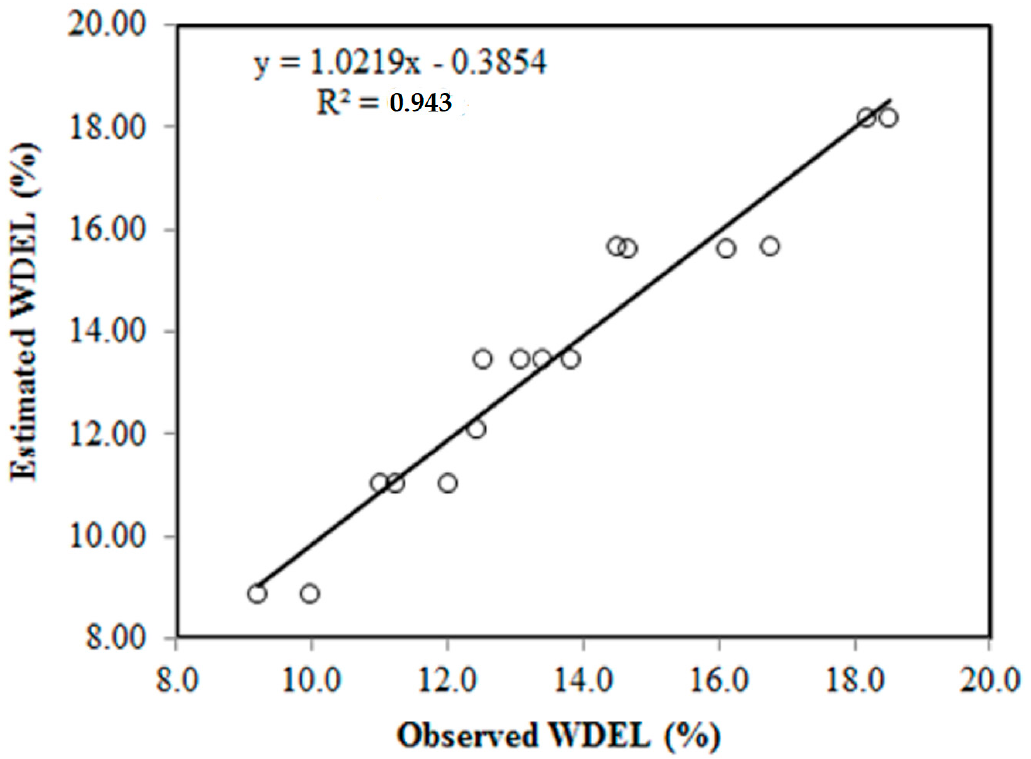
Figure 3. Scatter plot of estimated WDEL values using ANN model against observed values of testing data set.